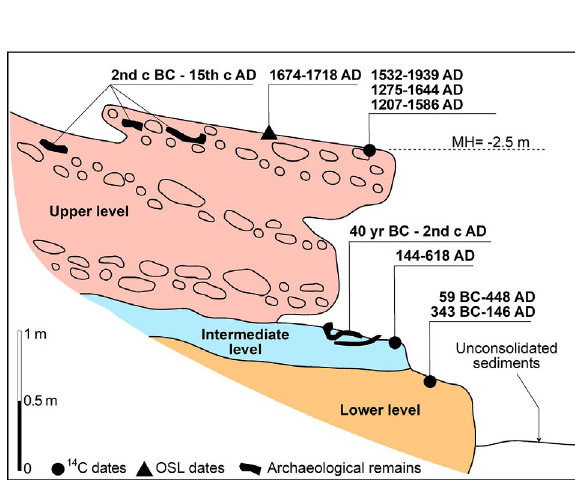
Length varies between a 8 and of 1039 m.